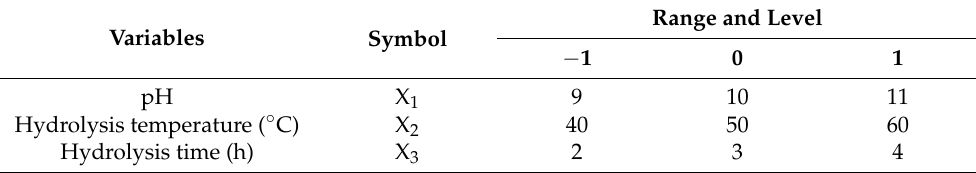
Table 2. Response surface factors and